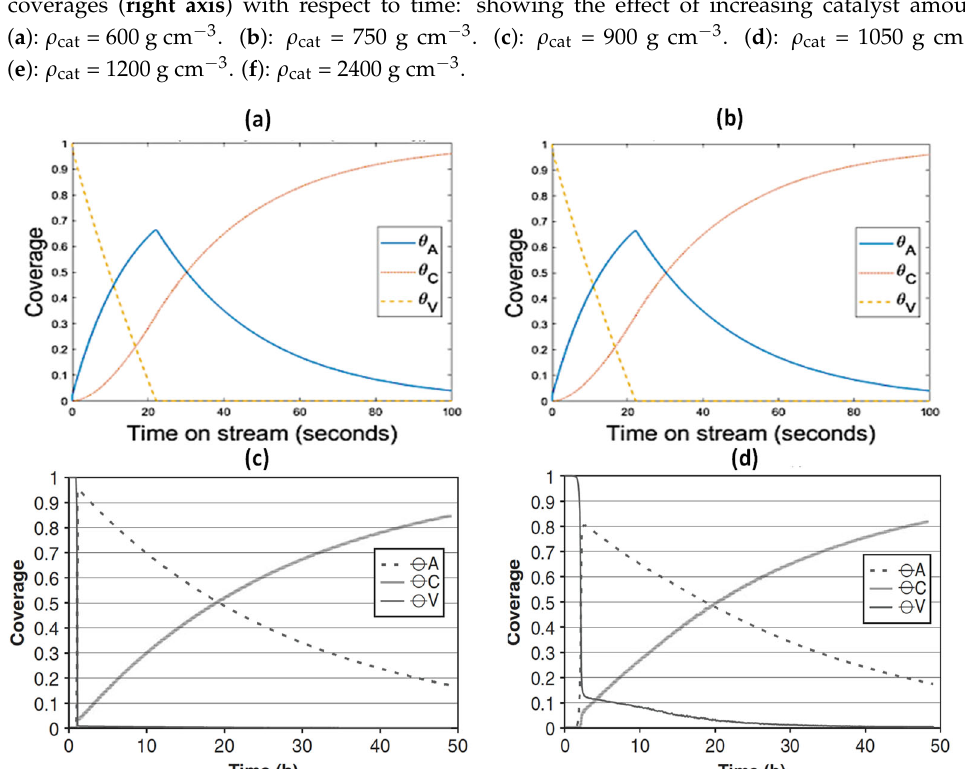
Figure 10. Estimated surface compound coverages: Comparison between CSTR (present study) and PFR (literature study), ( a ) mechanism I (elementary model, CSTR), ( b ) mechanism I (reduced k 1 by 20% and increased k − 1 by 10%, CSTR), ( c ) literature (elementary model, PFR), ( d ) literature (reduced k 1 by 20% and increased k − 1 by 10%, PFR.